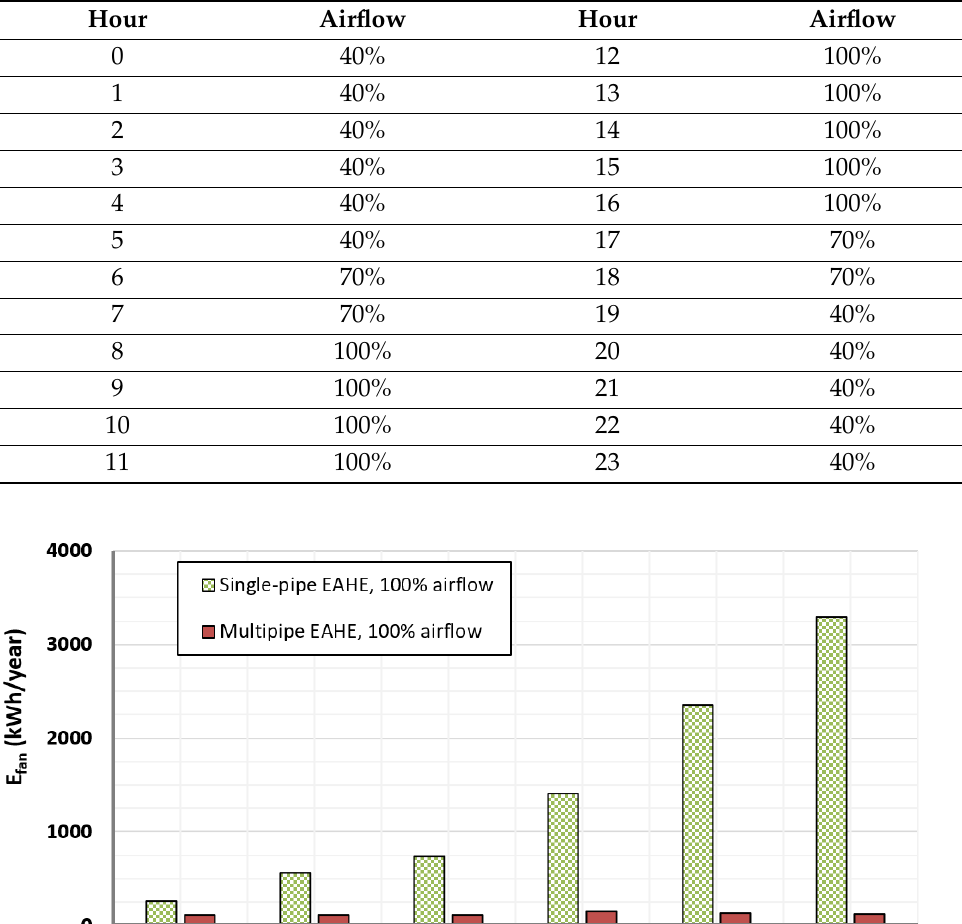
Table 4. Daytime ventilation airflow schedule assumed during calculations.